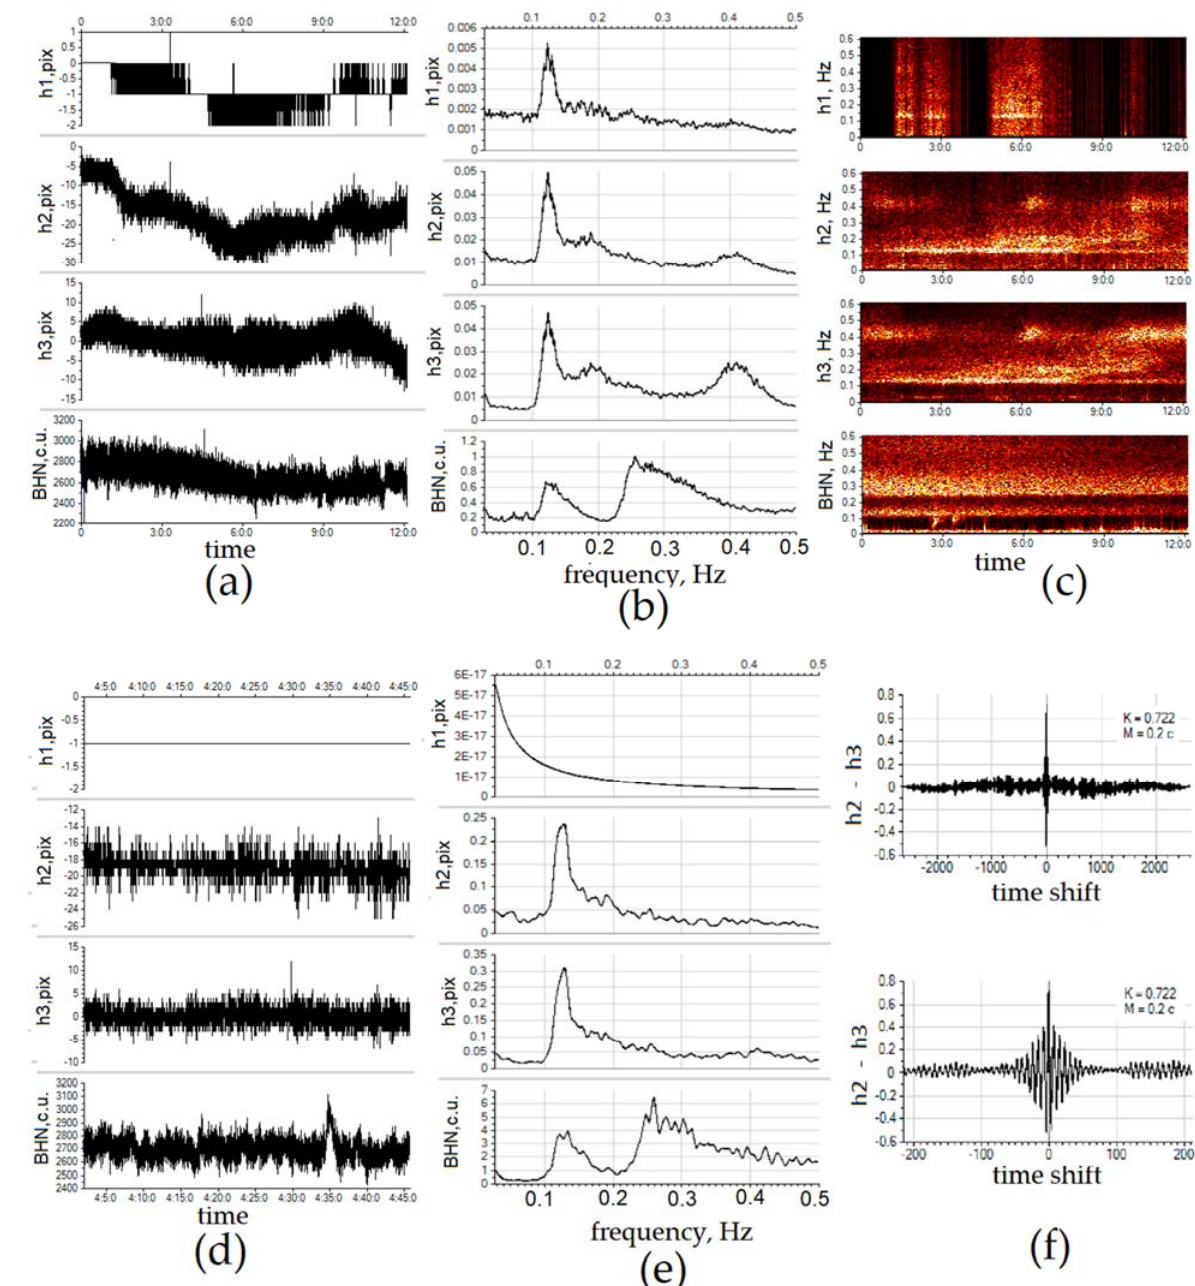
Figure 14. Results of the experimental study to investigate the possibility of using bicubic interpolation of a video stream 16 for tracking the movements of anchored objects on the sea surface with the QAVIS program with subpixel accuracy. Oscillograms ( a ), spectra ( b ), spectrograms ( c ) of QAVIS signals h1, h2, h3, and seismic signal BHN, recording duration 12 h. Oscillograms ( d ) and spectra ( e ) of the same signals at a 44 min time interval, when the signal h1 was strictly constant. Correlation function between signals h2 and h3 over the entire interval of time shifts and on its central part ( f